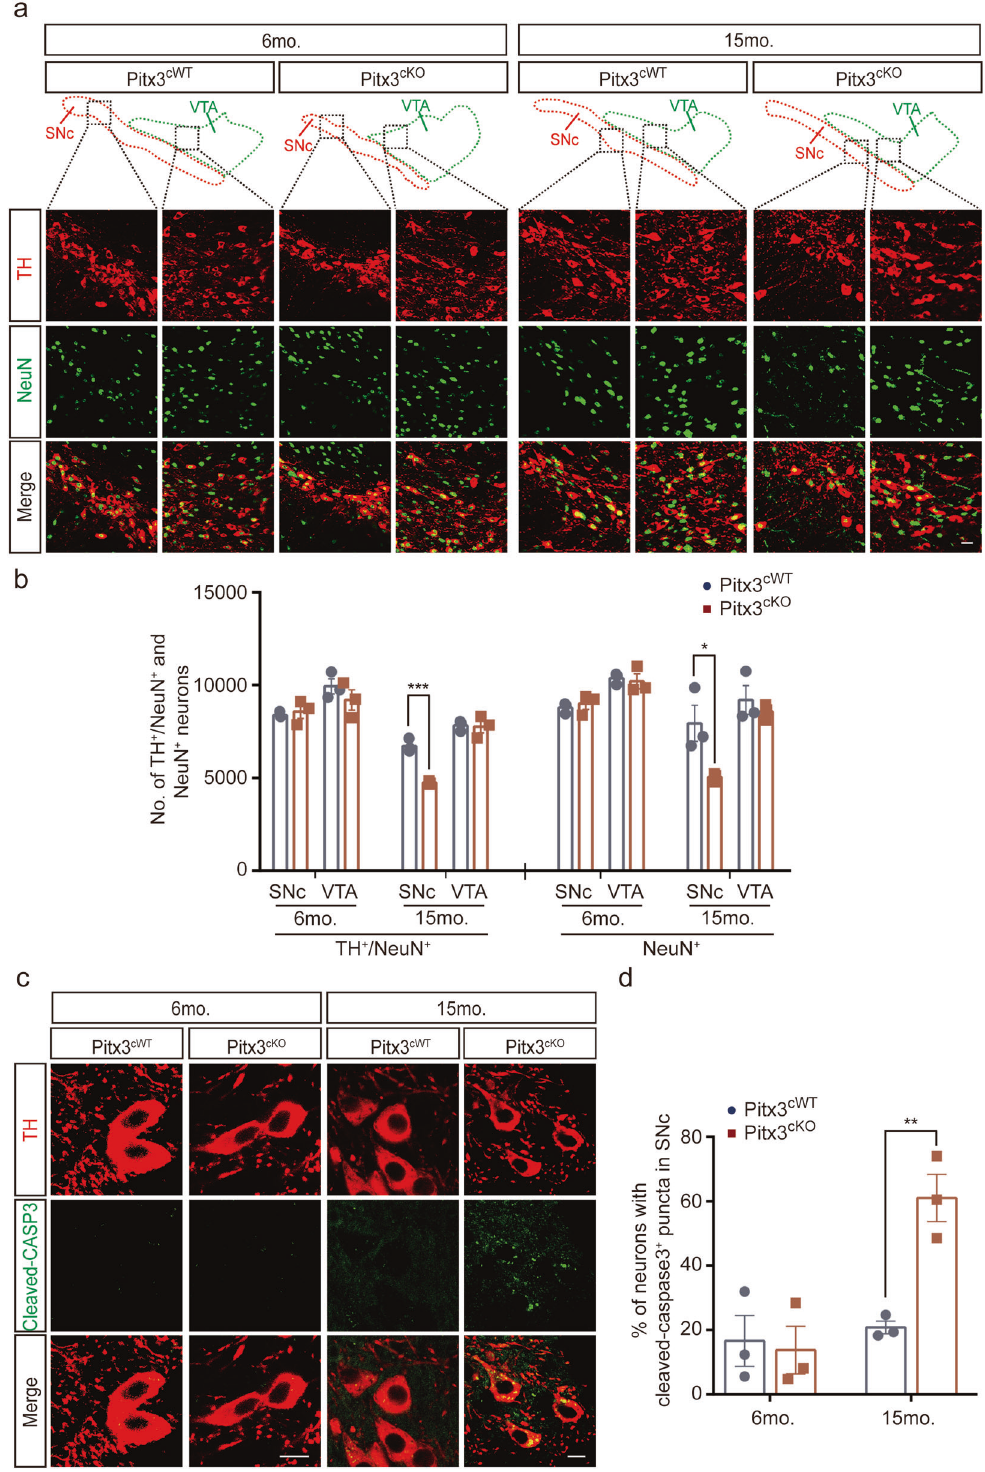
Fig. 3 Neurodegeneration in 15-month-old Pitx3 cKO mice accompanied by the promoted apoptosis. a IFC co-staining of TH and NeuN, and IFC staining of NeuN in the ventral midbrain sections from 6 and 15-month-old Pitx3 cWT and Pitx3 cKO mice. SNc and VTA were outlined, respectively (scale bar: 10 μ m). b Quanti fi cation of TH + /NeuN + and NeuN + neurons in the SNc and VTA from 6- and 15-months-old Pitx3 cWT and Pitx3 cKO mice ( N = 3 mice per genotype). unpaired t -test, *** p = 0.0008 (15 months old for TH + /NeuN + co-staining); unpaired t -test, * p = 0.0424 (15 months old for NeuN + staining). c IFC staining of cleaved-caspase3 in the SNc area from 6 and 15-month-old Pitx3 cWT and Pitx3 cKO mice (scale bar: 10 μ m). d Quanti fi cation of the percentage of neurons with cleaved-caspase3 + puncta in SNc ( N = 3 mice per genotype). unpaired t -test, ** p =